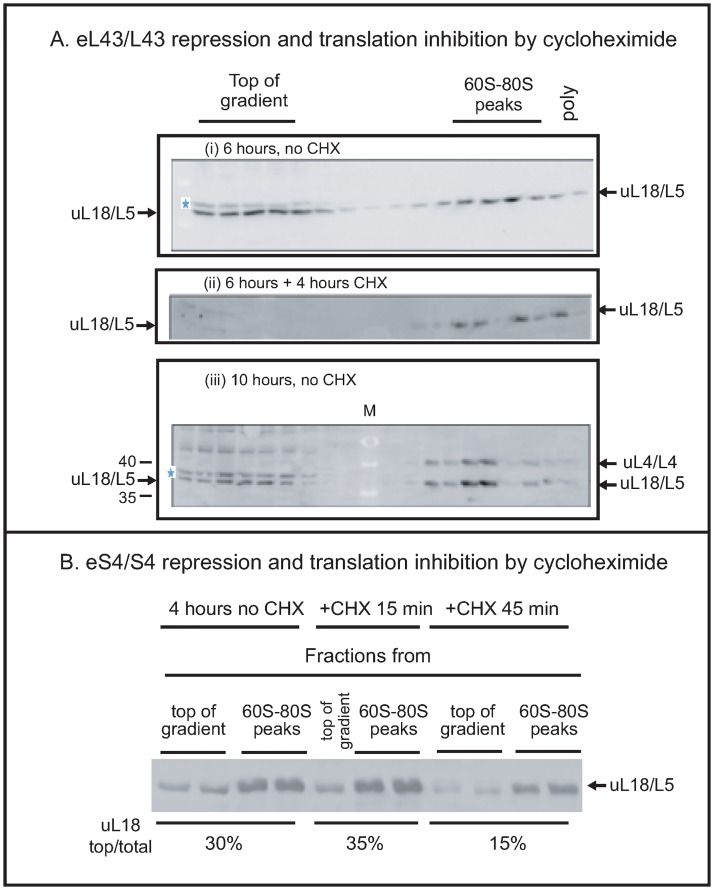
Maintenance of the extra-ribosomal uL18 pool requires protein synthesis.(A) Cycloheximide decreases the pool of extra-ribosomal uL18/L5 during the repression of a 60S r-protein gene. Six hours after shifting Pgal-eL43/L43 from galactose to glucose medium, cycloheximide was added to an aliquot of the culture (final concentration: 100 μg/ml), while the culturing of another aliquot of the culture was continued without addition of the drug. Both aliquots were harvested 10 hours after the shift. Whole-cell extracts were analyzed by sucrose gradients and western blots of aliquots of all sucrose gradient fractions. (i) Pgal-eL43/L43 6 hours after the shift of media, (ii) Pgal-eL43/L43 incubated with cycloheximide added 6 hours after the media shift and harvested 10 hours after the shift. (iii) Pgal-eL43/L43 incubated for 10 hours in glucose without cycloheximide. All fractions from the top through the polysome region of the sucrose gradient are shown. (B) Cycloheximide also decreases the pool of extra-ribosomal uL18/L5 during the repression of a 40S r-protein gene. Pgal-eS4/S4 was grown in galactose medium and shifted to glucose medium. Cycloheximide (100 μg/ml) was added to the culture 6 hours after the shift and cells were harvested 0, 15 and 45 minutes after addition of the drug. Aliquots of one or two fractions from the top of the gradient and two fractions from the 60S-80S peaks were analyzed by western blots probed with anti-uL18/L5. Consecutive fractions from the top and the 60S-80S region of the sucrose gradient were shown. M Molecular weight markers in kD. 35 and 40 kD are identified. See S2 Fig for the full molecular weight ladder.